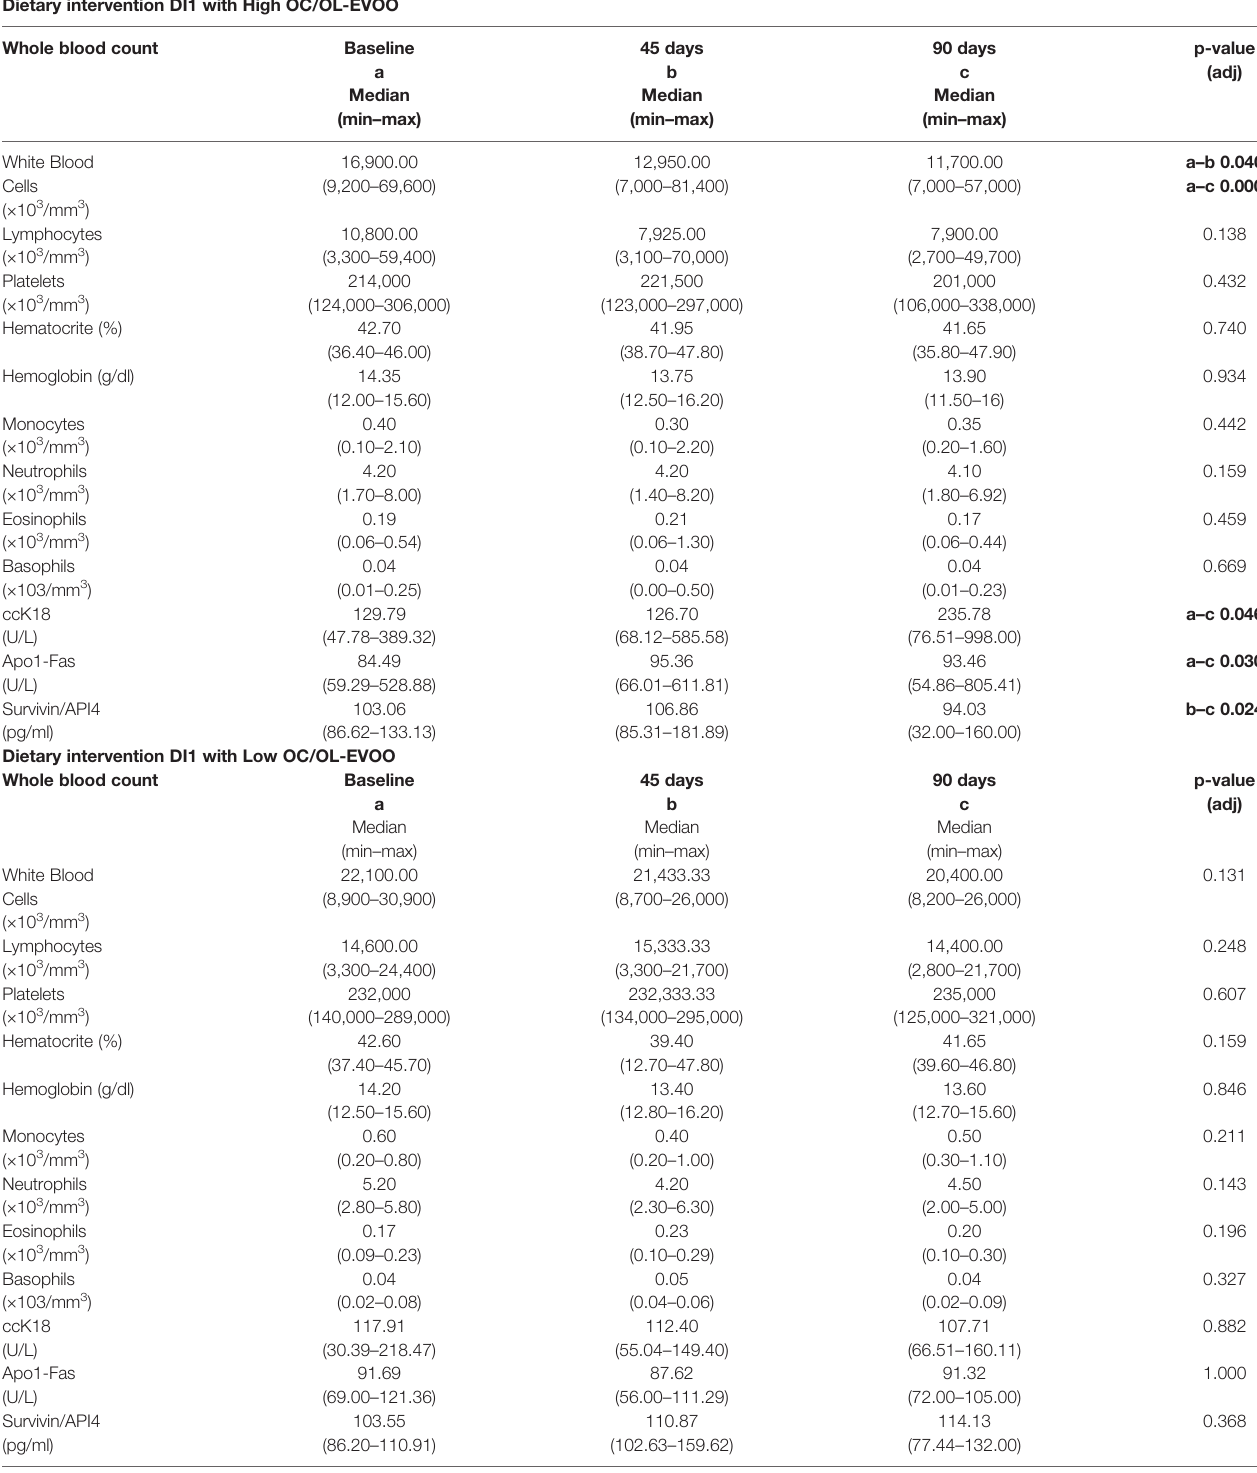
TABLE 1 | Differences in hematological and apoptotic markers of patients with CLL before and during the intervention DI1 with high OC/OL-EVOO (10 patients) and low OC/OL-EVOO (10 patients). a Dietary intervention DI1 with High